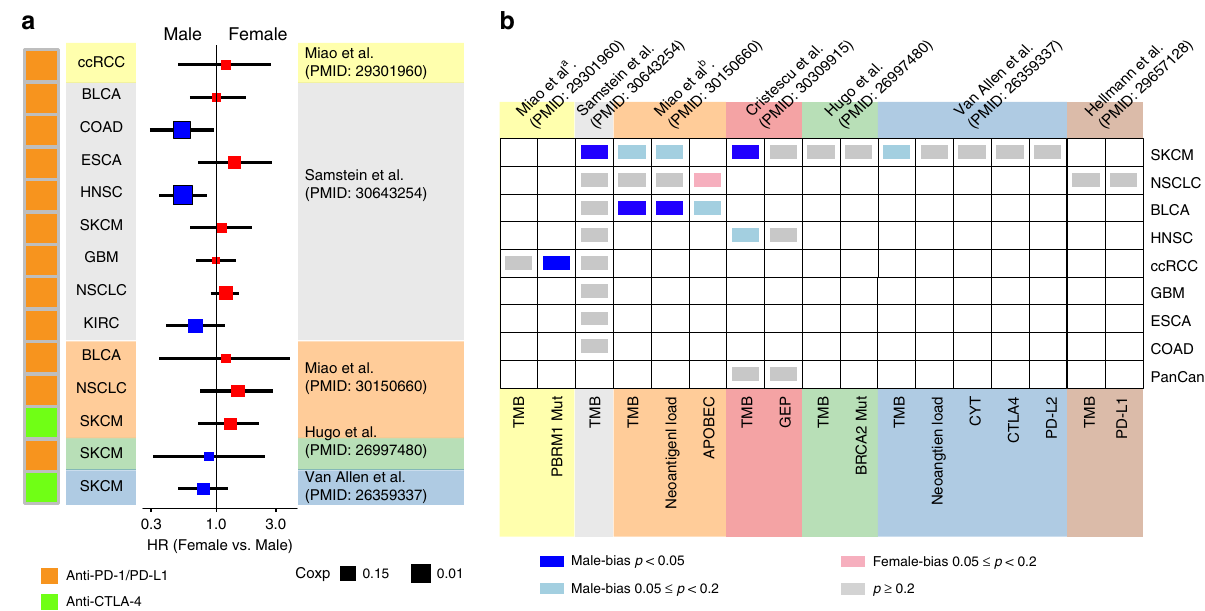
Fig. 2 Clinical outcomes and molecular differences between male and female patients with ICB treatment. a Univariate survival analysis in the Cox proportional hazard model for female patients with immunotherapy treatment compared with male patients in nine cancer types from fi ve data sets. Square color indicates OS advantage in female (red) or male (blue). Square size indicates the signi fi cance of cox p -value. Black horizontal lines indicate the 95% CI. b The gender difference for molecular biomarkers reported for immunotherapy ( x axis) across multiple cancer types ( y axis) in seven immunotherapy data sets. Two-sided Wilcoxon – Mann – Whitney test was used for continuous variables and Fisher ’ s exact test was used for discrete variables. Blue cell: male-bias with p < 0.05, light blue cell: male-bias with 0.05 ≤ p < 0.2, pink cell: female-bias with 0.05 ≤ p < 0.2. Empty cells indicate the unavailability of data. Sample size for each data set was listed in Supplementary Table 2. ccRCC clear cell renal cell carcinoma, BLCA bladder cancer, COAD colorectal cancer, ESCA esophagogastric cancer, GBM glioma, HNSC, head and neck cancer, NSCLC non-small-cell lung cancer, PanCan multiple cancer types with small sample size. PD-L1/PD-L2 programmed cell death ligand 1/2, CTLA-4 cytotoxic T-lymphocyte antigen-4. GEP T cell-in fl amed gene expression pro fi le, CYT cytolytic